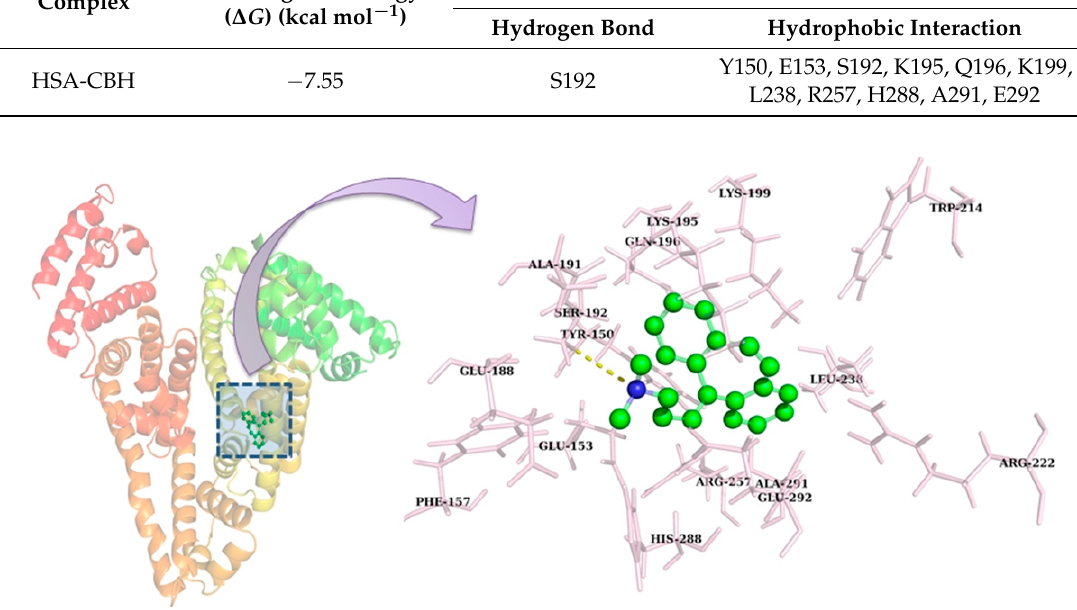
Table 5. Binding of CBH within the active site of HSA and the residues involved in binding. Complex Binding free energy ( Δ G )